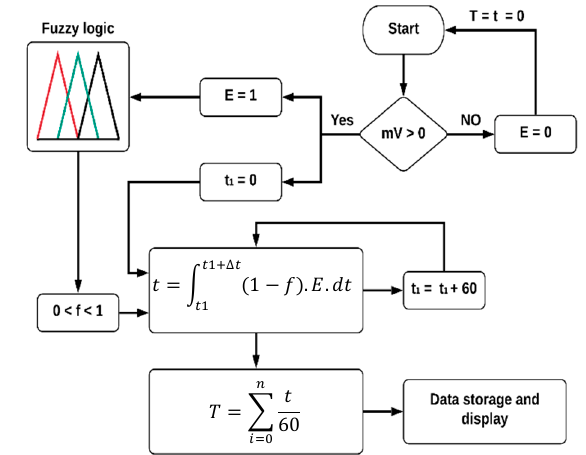
Figure 7. Algorithm for the sunshine duration (SD) calculation.